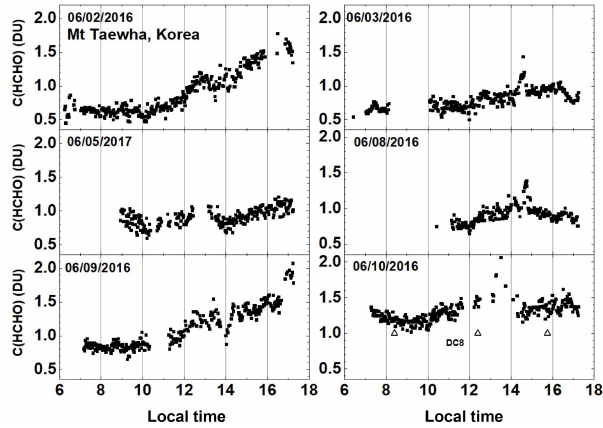
Figure 18. Total column HCHO from Pandora Taehwa Mountain for 6 days in June 2016. C(HCHO) on 2 June 2016 has a peak value of 1.2DU at 12:45. (cid:49) are DC-8 CAMS measurements on 10 June.